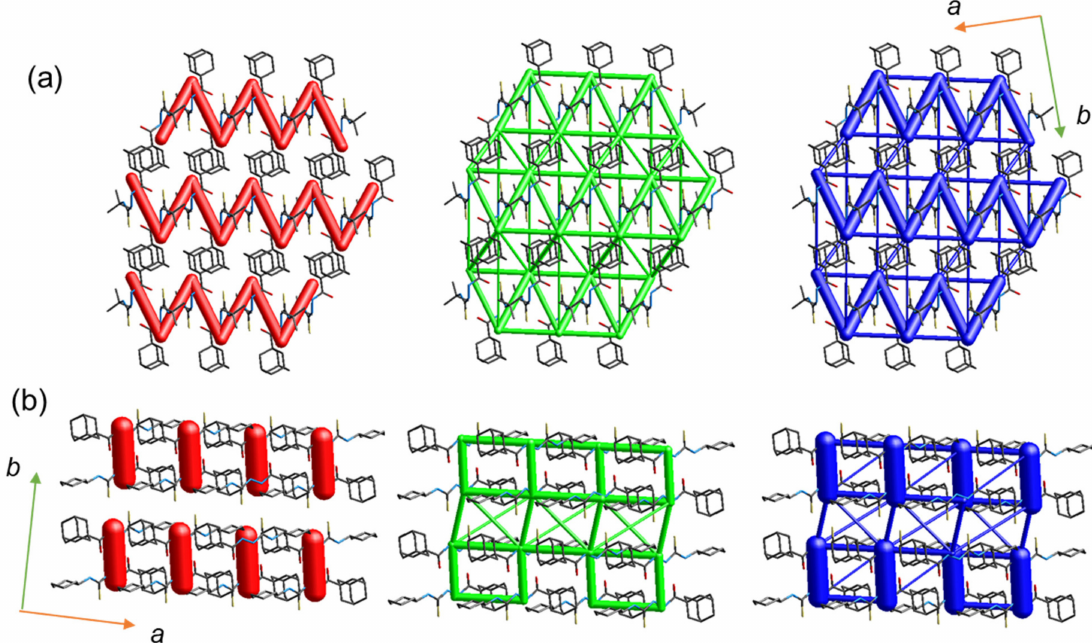
Figure 5. Energy frameworks for the crystal structure of ( a ) 1 and ( b ) 2 . The electrostatic (red), dispersion (green) and total interaction (blue) energies are represented as cylindrical tubes with size 80. The interaction energies with magnitudes smaller than − 15 kJ mol − 1 have been omitted for